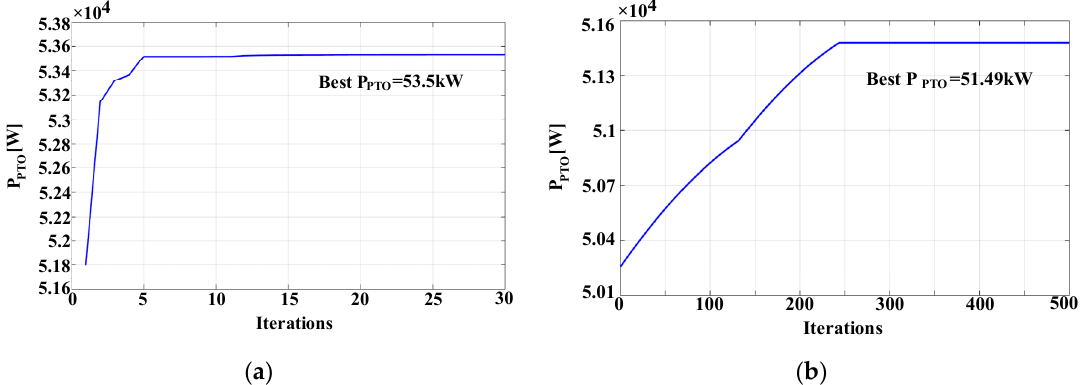
Figure 7. Simulated average power obtained by ( a ) FPA, ( b ) hill-climbing method.